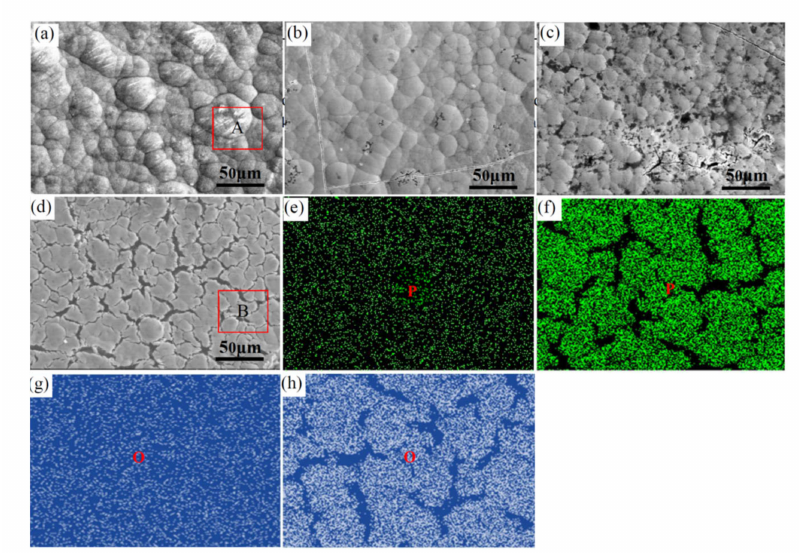
Figure 13. SEM and EDS images of the NiP alloy coatings before and after immersion: ( a ) as-deposited coating, coatings immersed for ( b ) 12, ( c ) 24, ( d ) and 72 h, ( e , g ) P and O surface distribution in the as-deposited coating, and ( f , h ) P and O surface distribution after 72-h immersion.